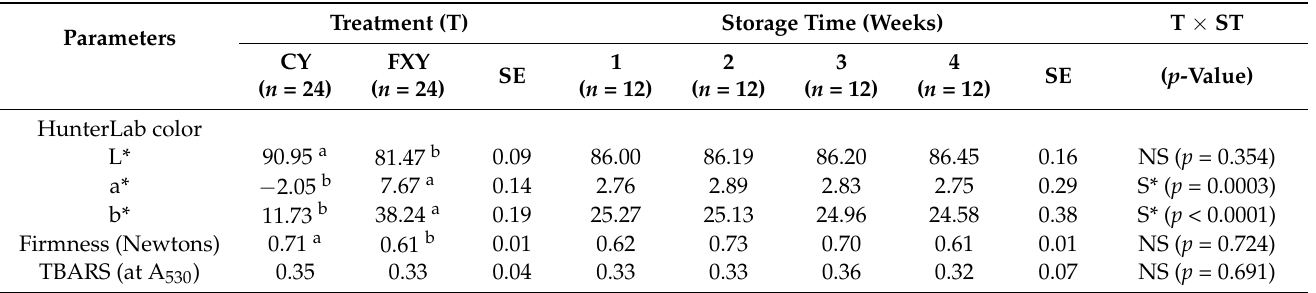
Table 6. Effect of fucoxanthin supplementation on HunterLab color, firmness, and lipid oxidation of goat whole milk yogurt during storage.